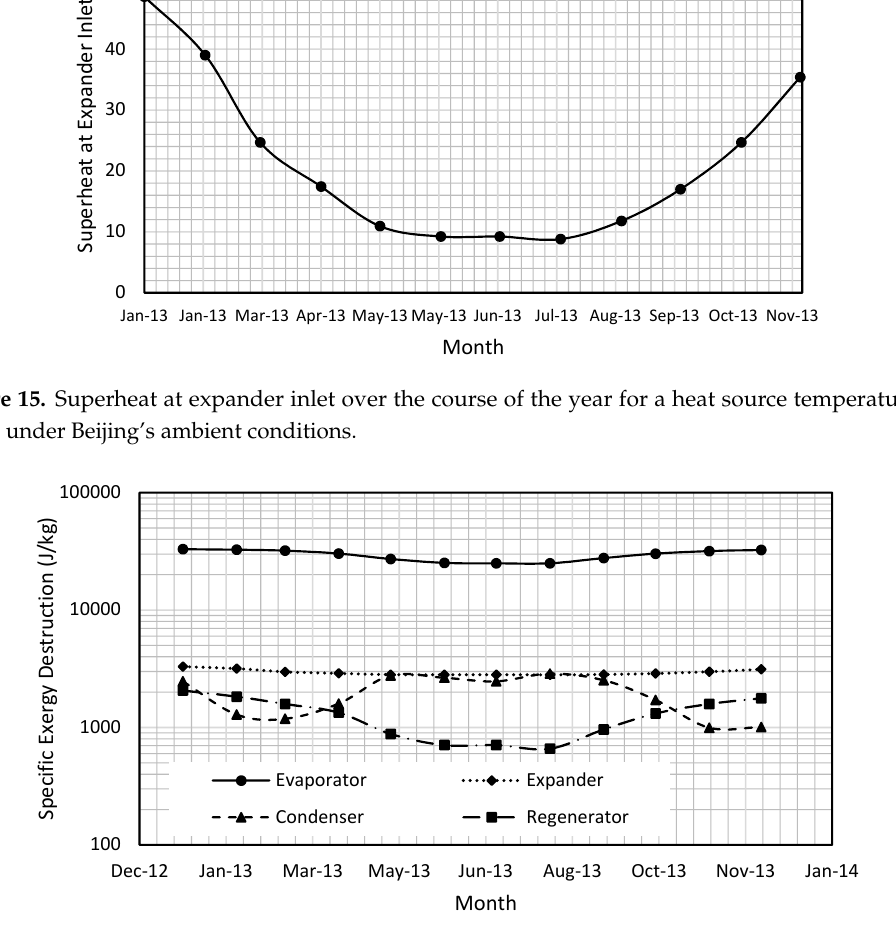
Figure 16. Variation in exergy destruction in each cycle component over the course of the year for a heat source temperature of 75 °C with a recuperator.